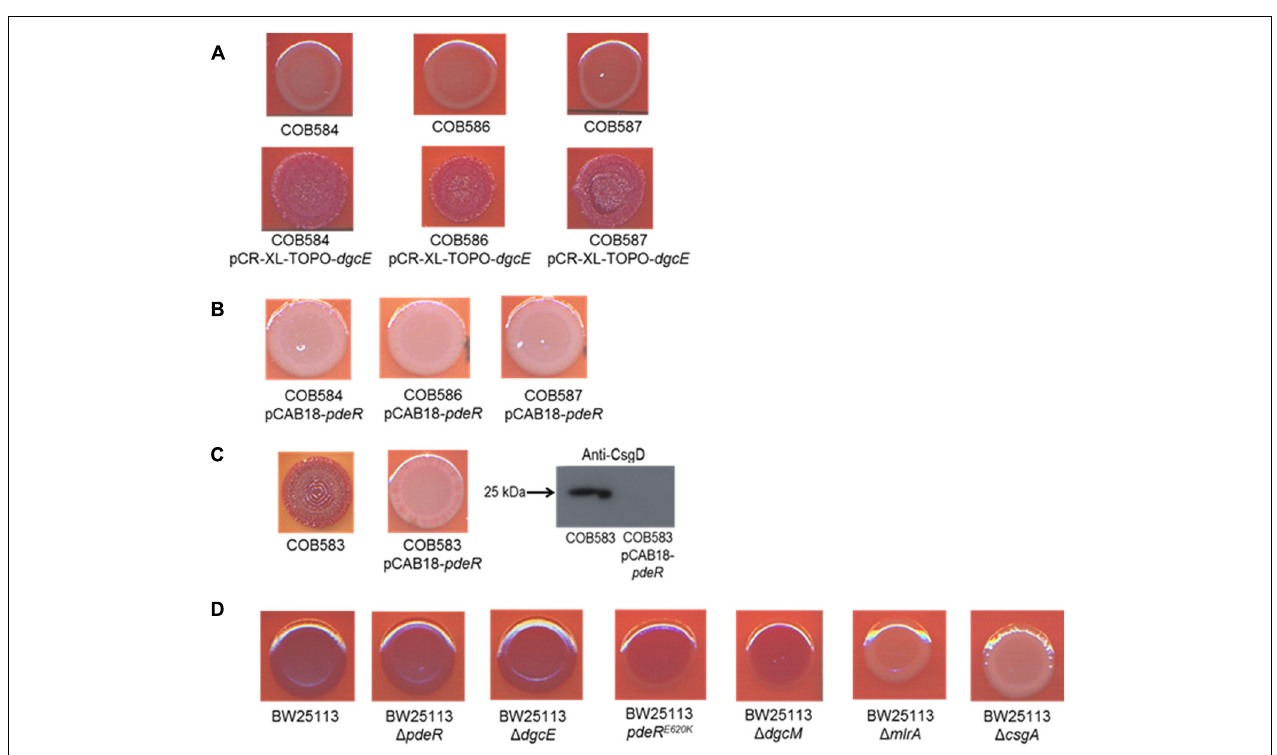
FIGURE 6 | Complementation of curli-negative soil-persistent Escherichia coli with (A) wildtype DgcE restored curli production, and (B) PdeR had no effect on curli production. Curli-negative E. coli were transformed with pCR-XL-TOPO plasmid carrying wildtype dgcE , and pCAB18 plasmid carrying wildtype pdeR , grown on Congo Red-containing Yeast Extract and Casamino acid agar (CR-YESCA) at 28 ◦ C for 48 h. (C) Curli production in curli-positive soil-persistent E. coli with wildtype pdeR reduced curli production and CsgD protein. (D) Curli production among BW25113 deletion mutants grown on CR-YESCA at 28 ◦ C for 48 h.